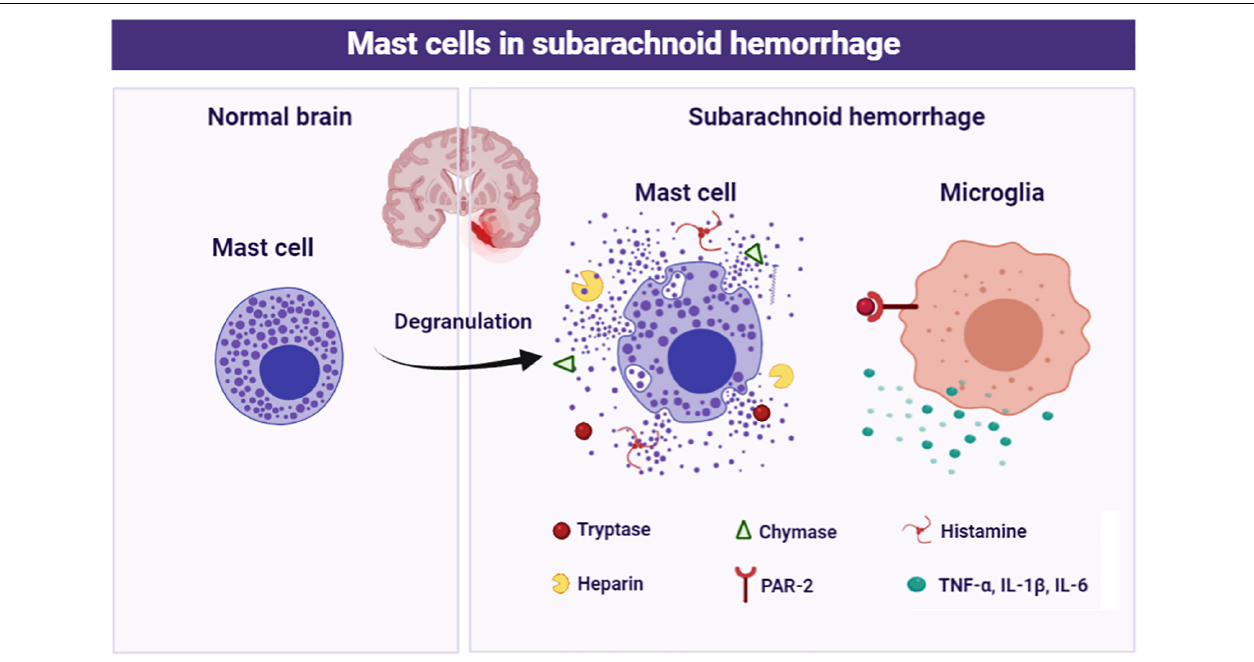
FIGURE 8 | Schematic diagram of MCs in the pathological process following SAH. MCs are rapidly activated and degranulation in response to SAH. Subsequently, MCs-derived tryptase binds to PAR-2 on microglia, resulting in microglial activation and ultimately mediate inflammatory